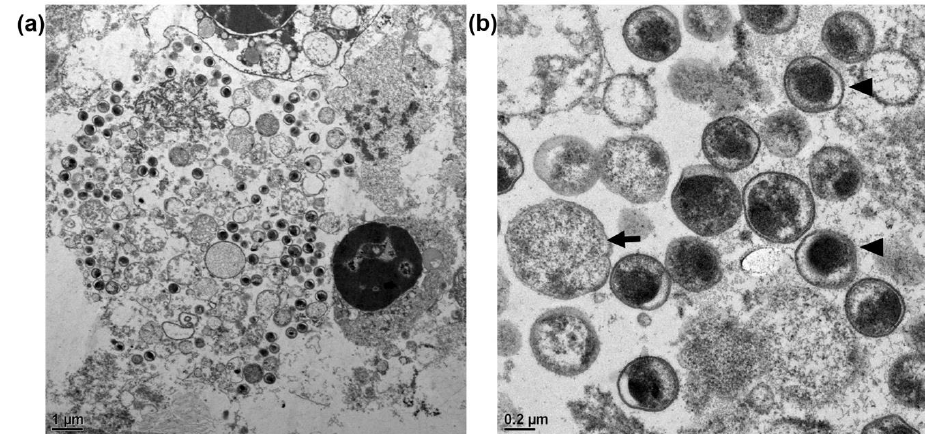
Figure 2. Transmission electron microscopy images of Chlamydia psittaci . ( a ) The cytoplasm of infected cells is occupied by numerous variably sized vesicles of different electron densities. ( b ) The elementary bodies of C. psittaci are small electron-dense spherical bodies, ranging in diameter from 0.4 to 0.5 µ m, with distinct periplasmic electron-transparent spaces (arrowheads). The reticulate bodies (arrow), ranging in diameter from 0.5 to 1.5 µ m, are characterized by large amounts of granular cytoplasm.